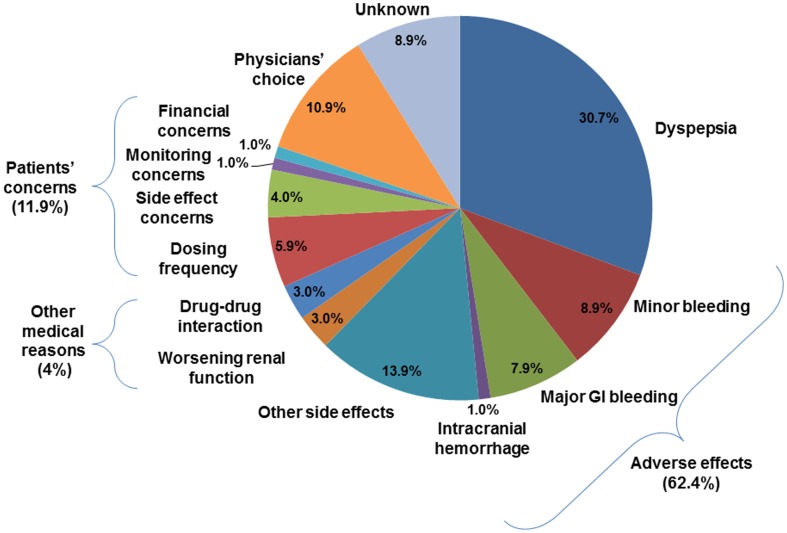
Reasons of discontinuation of dabigatran.